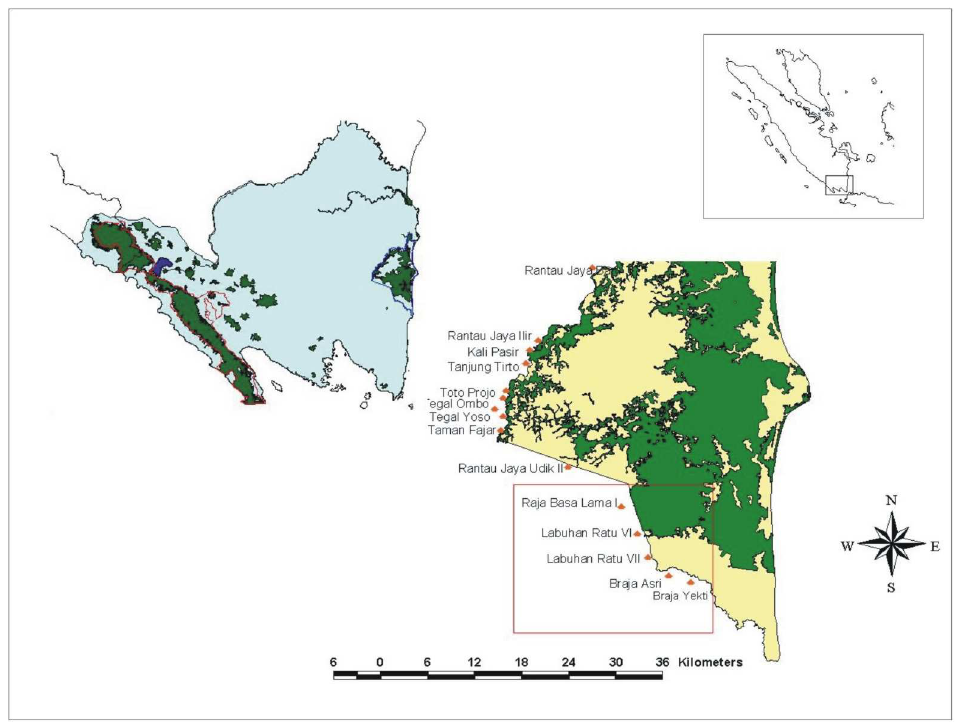
Fig 1. Project area in and around Way Kambas National Park (WKNP), Sumatra, Indonesia. The top right panel depicts the islandof Sumatra in relationto Peninsular Malaysia and Java, with the study area in a box. The left panel depicts the boxed area in greater detail with remainingforest cover shown in green. The bottom right panel shows WKNP and the 16 villages mentioned in the text. Figure used by permissionof the Wildlife ConservationSociety (WCS), originalcopyright owner [originalcopyrightyear 2007], under a CC BY license.